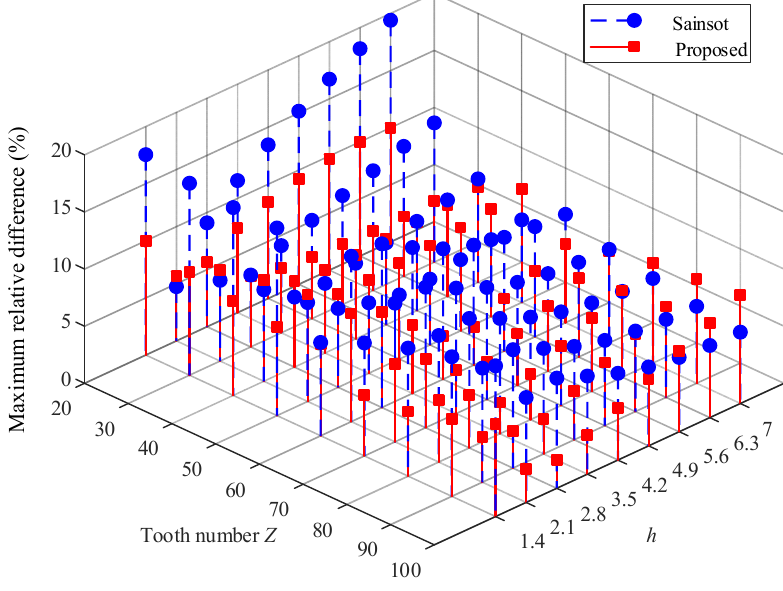
Figure 12. Performance comparison in the single-tooth-pair meshing duration.